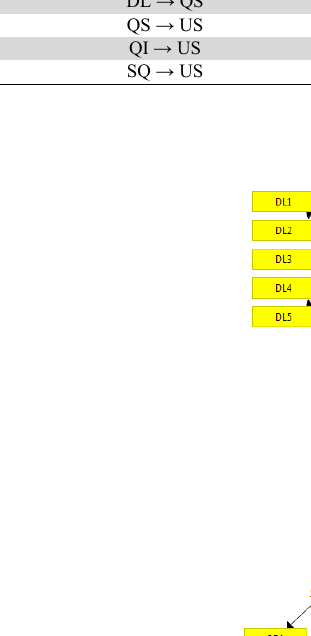
Fig. 3. Hypothesis